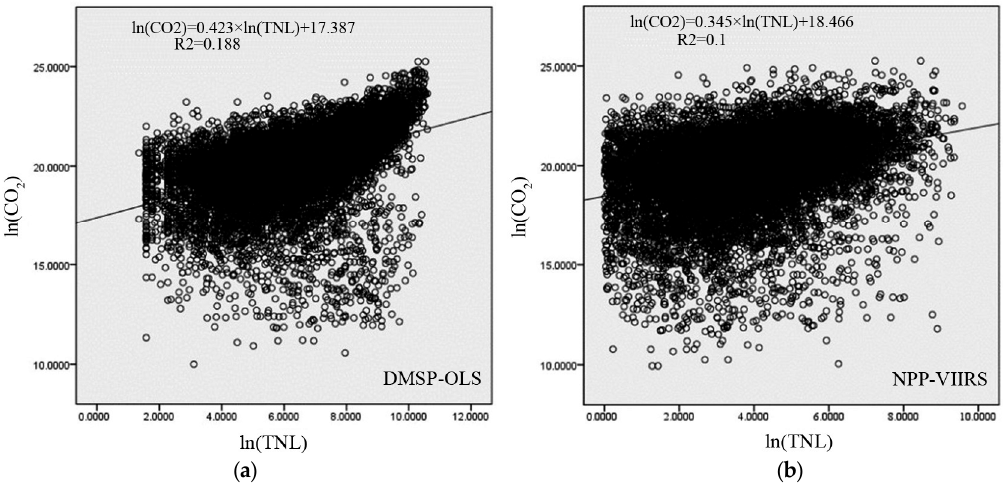
Figure 5. ( a , b ) Scatter plots of log-log regression model at 0.1° × 0.1° grid for DMSP-OLS ( a , b ) Scatter plots of log-log regression model at 0.1 ◦ × 0.1 ◦ grid for and NPP-VIIRS.